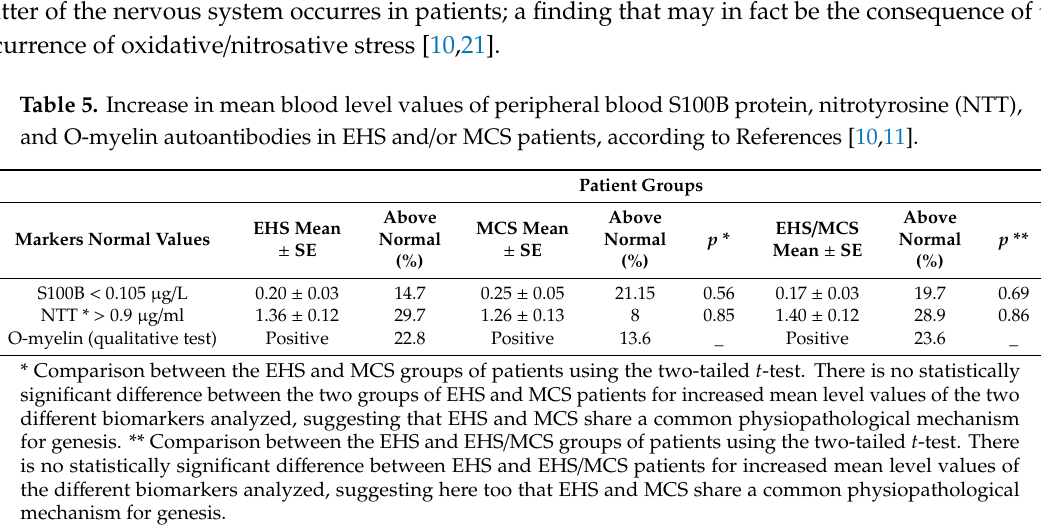
Table 5. Increase in mean blood level values of peripheral blood S100B protein, nitrotyrosine (NTT), and O-myelin autoantibodies in EHS and / or MCS patients, according to References [10,11]. Markers Normal